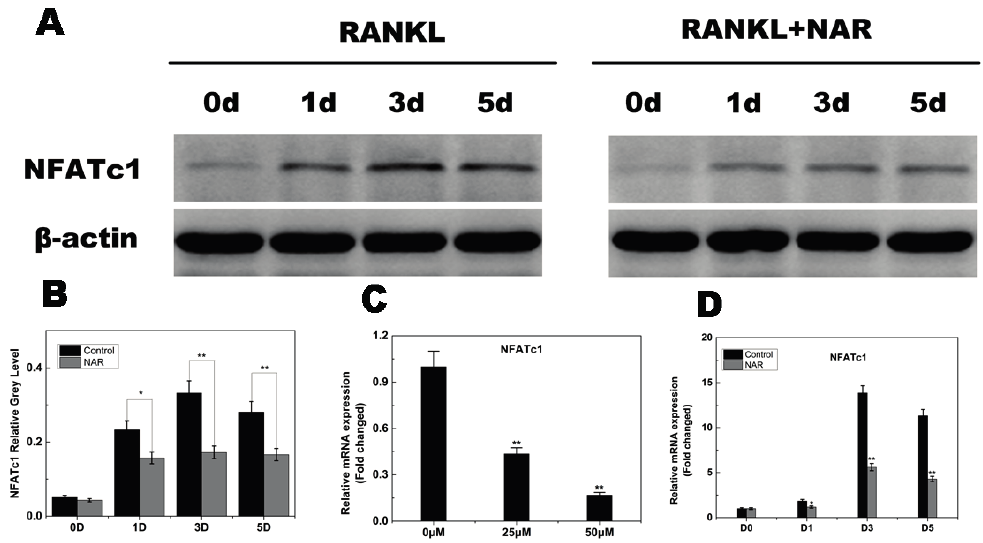
factor- κ B ligand (RANKL)-induced nuclear factor of activated T cells c1 (NFATc1) signaling. ( A ) Suppression of RANKL-induced NFATc1 signaling by NAR (200 μ M); ( B ) Quantitative analysis of NFATc1 expression; ( C ) Levels of the indicated NFATc1 mRNAs following exposure to NAR (0, 25, or 50 μ M); ( D ) Levels of the indicated NFATc1 mRNAs following exposure to 50 μ M NAR for 0, 1, 3, or 5 days. * p < 0.05; ** p <